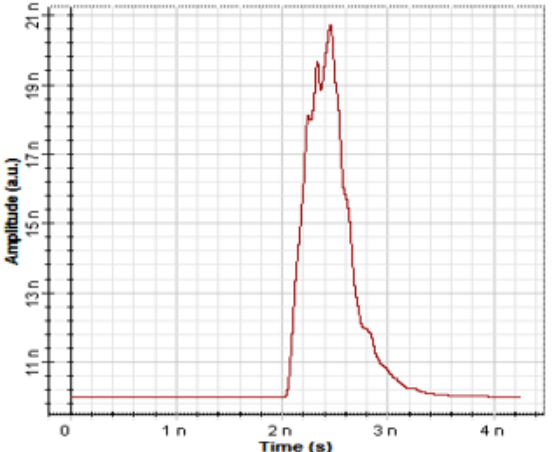
Figure 16. Irradiance angle ( θ s ) effect on an LOS propagation model ( θ s changes from 30 ◦ to 50 ◦